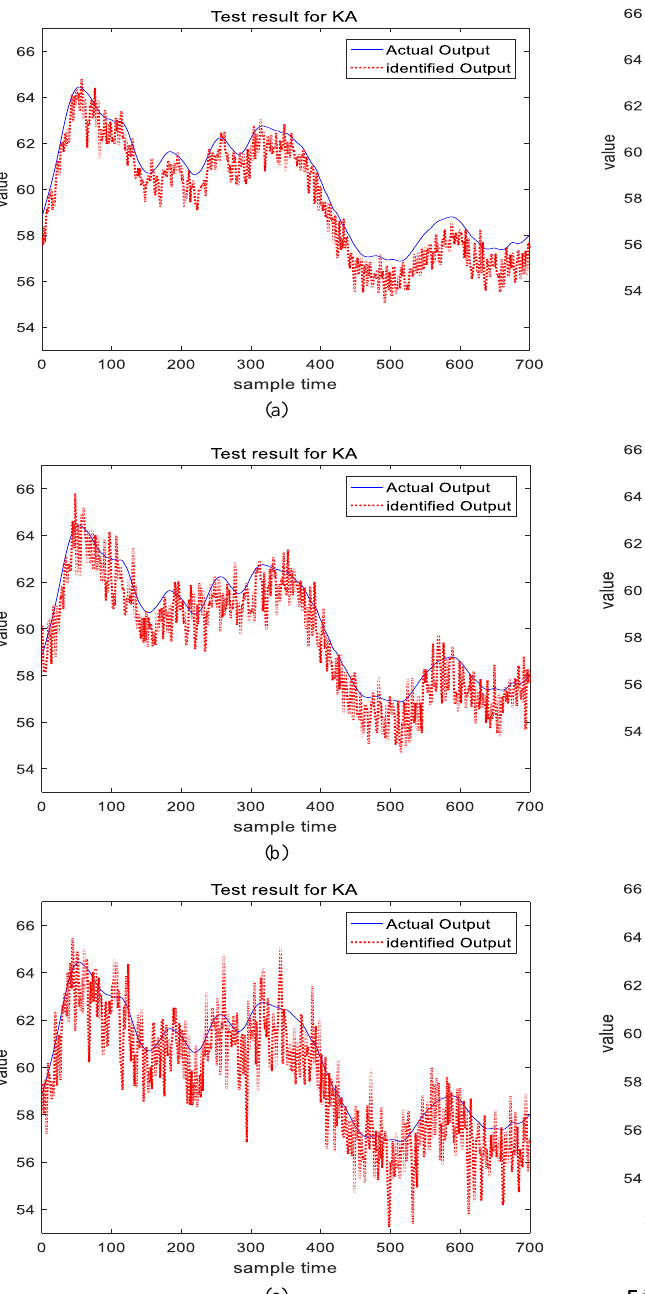
Figure 7. Plot of actual and identified output for KA in case 𝛔 𝐓𝐞𝐬𝐭 = 0.7 and (a) 𝛔 𝐓𝐫𝐚𝐢𝐧 = 0.7 (b) 𝛔 𝐓𝐫𝐚𝐢𝐧 = 1 (c) 𝛔 𝐓𝐫𝐚𝐢𝐧